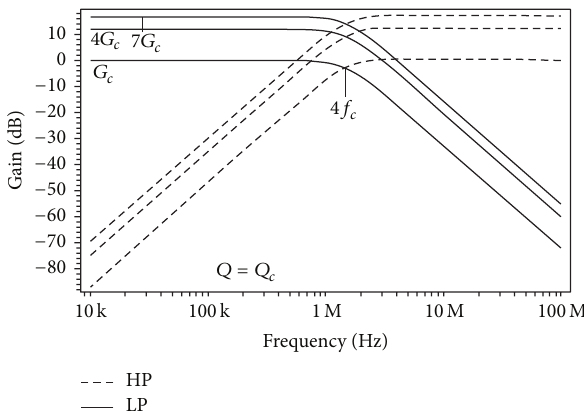
Figure 10: Gain programming of HP and